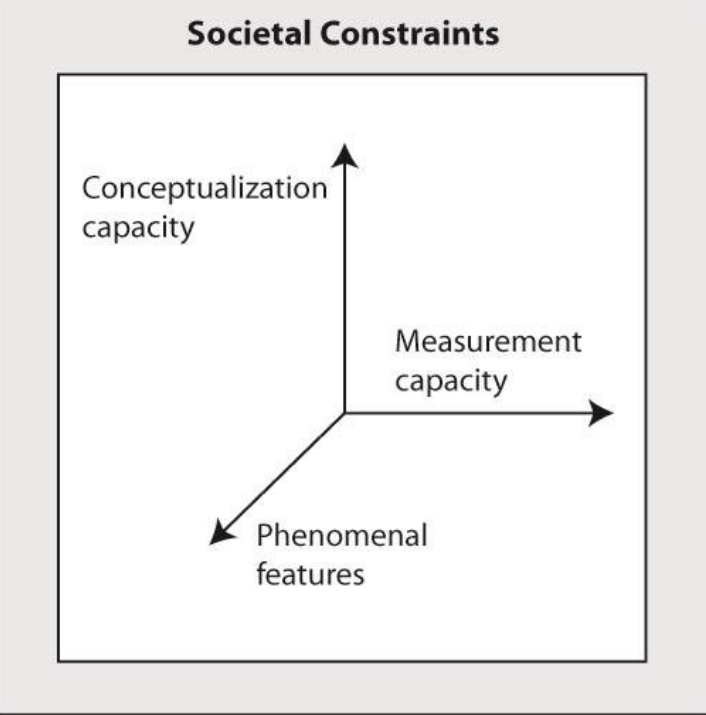
Figure 3. The Uncertainty Assessment Framework.